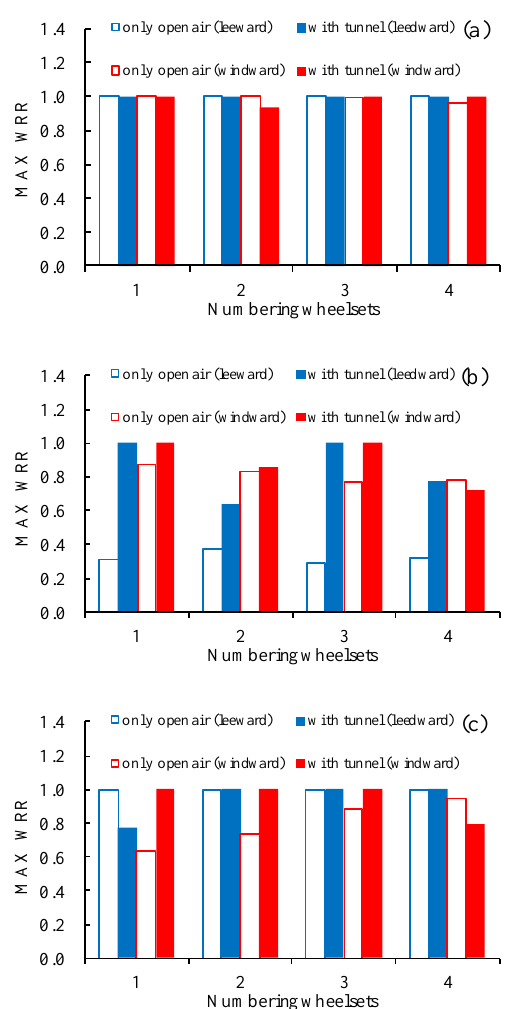
Figure 21. Contrast of global maximum wheel reduction rate conditioned train speed 250 km / h, crosswind velocity 25 m / s: ( a ) head, ( b ) middle, and ( c ) rear carriages.